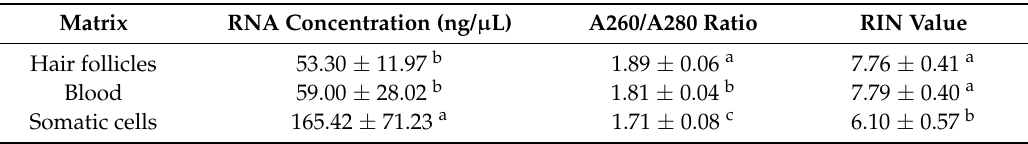
Table 1. The concentration of RNA, the ratio of absorbances at 260 and 280 nm (A260/A280), and the RNA integrity number (RIN) values of RNA isolated from the three matrices.